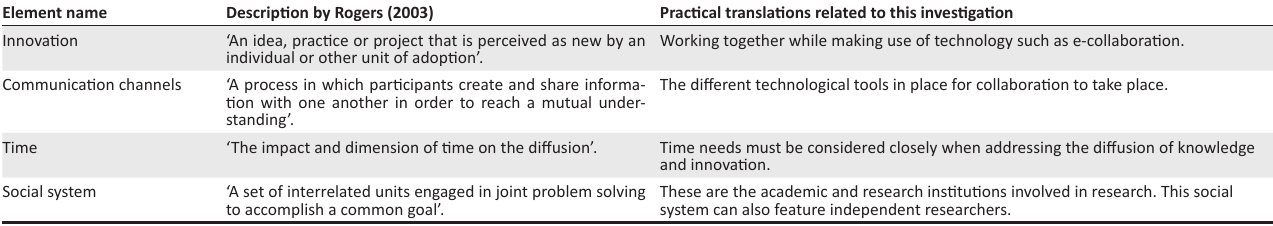
TABLE 2: Diffusion of innovation elements and practical